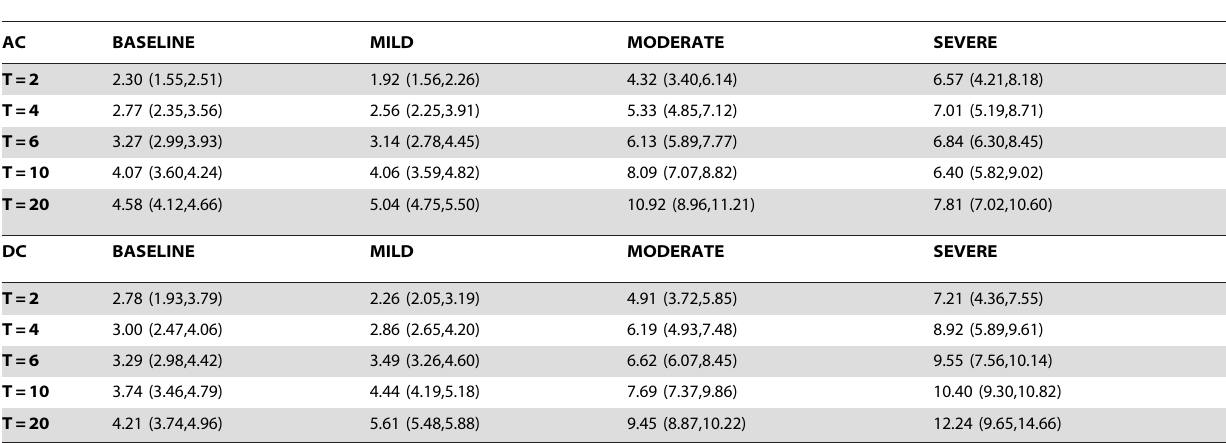
Table 3. AC and DC absolute median values (in ms) when considering the entire signal (including UCO-induced FHR